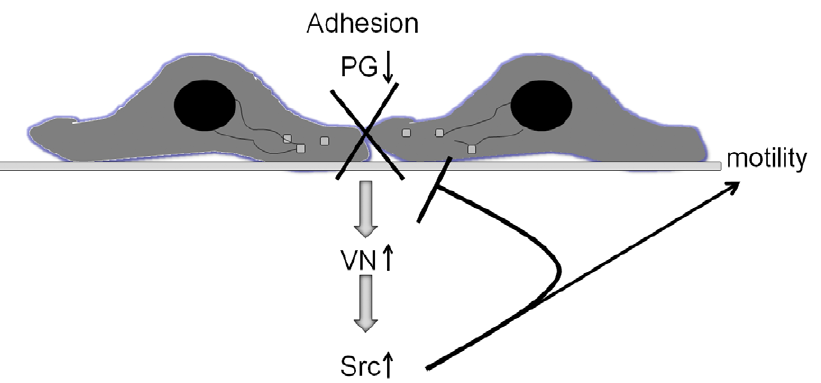
Figure 8. Model of the role of PG in prostate cancer adhesion and motility. Loss of PG results in a double negative hit on cell-cell junctions, while orchestrating alterations in extracellular matrix that promote motility. PG levels correspond directly to the strength of cell-cell adhesion in PCa cells. Down-regulation of PG leads to loss of cell-cell adhesion strength. Concomitantly, loss of PG causes up-regulation of VN and activation of Src. Together, these cell-cell and cell-ECM dependent effects of PG down-regulation lead to an increase in PCa cell motility.